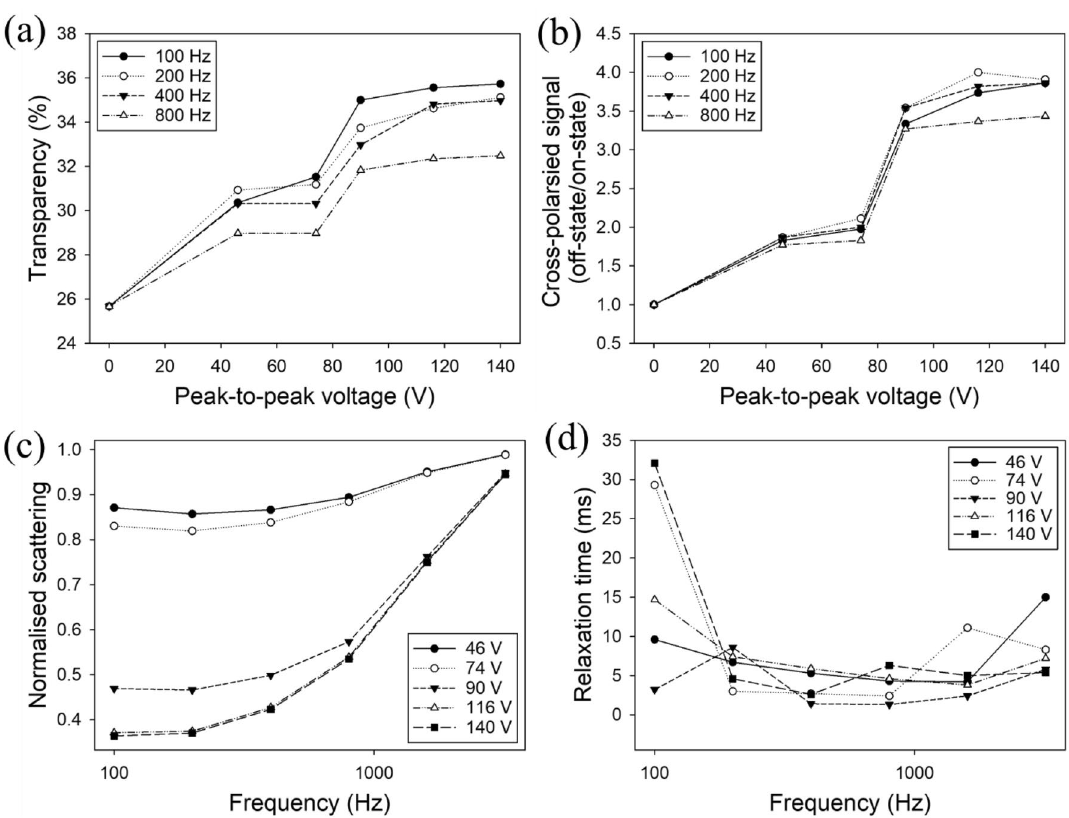
Figure 8. ( a ) Transparency against applied voltage for four different frequencies. ( b ) Repolarised signal normalised to off-state repolarised signal against applied voltage for four different frequencies of voltage. ( c ) Scattered light detected at an angle of 50° normalised to the off-state scattering against frequency of the applied voltage. ( d ) PDLC relaxation time against frequency for five